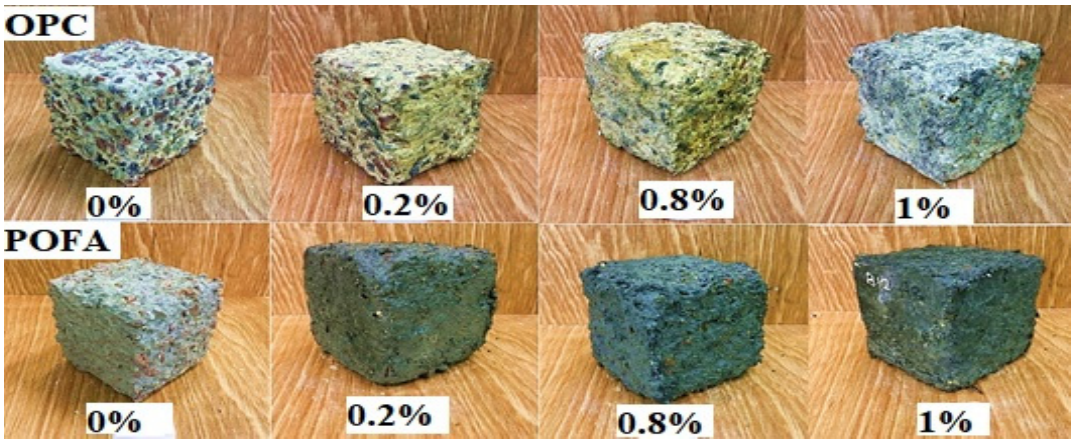
Figure 10. The appearance of various concrete specimens exposed to a H 2 SO 4 solution for 12 months.